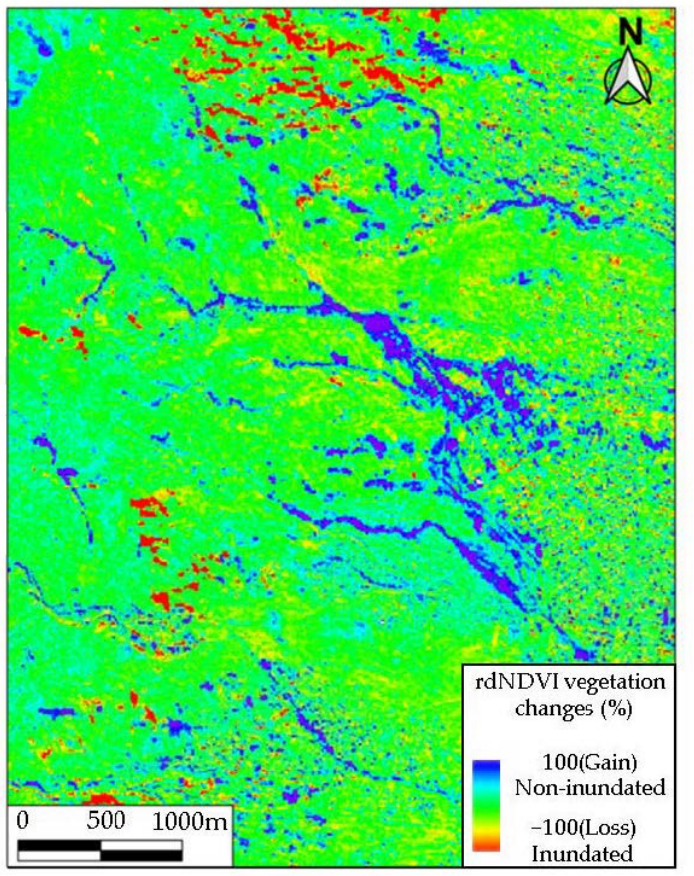
Figure 12. rdNDVI-based change detection image and greenest pixel composites (pre-event time: 2-months; post-event time: 16 days).